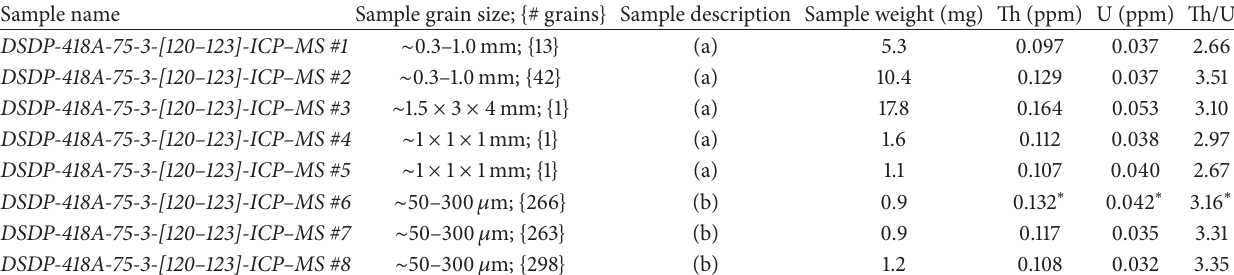
Table 1: ICP-MS results for U and Th concentrations in DSDP 418A basaltic